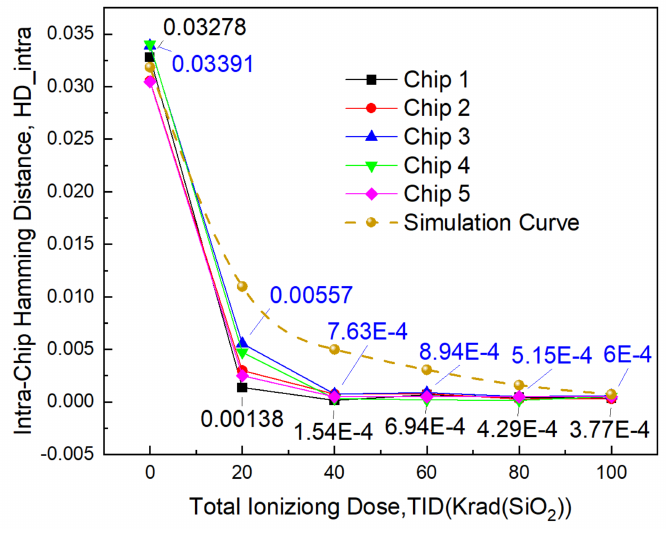
Figure 12. HD _ intra at each irradiation step, HD _ intra of all tested chips holds the magnitude of 10 − 4 after 40 Krad(SiO 2 ).